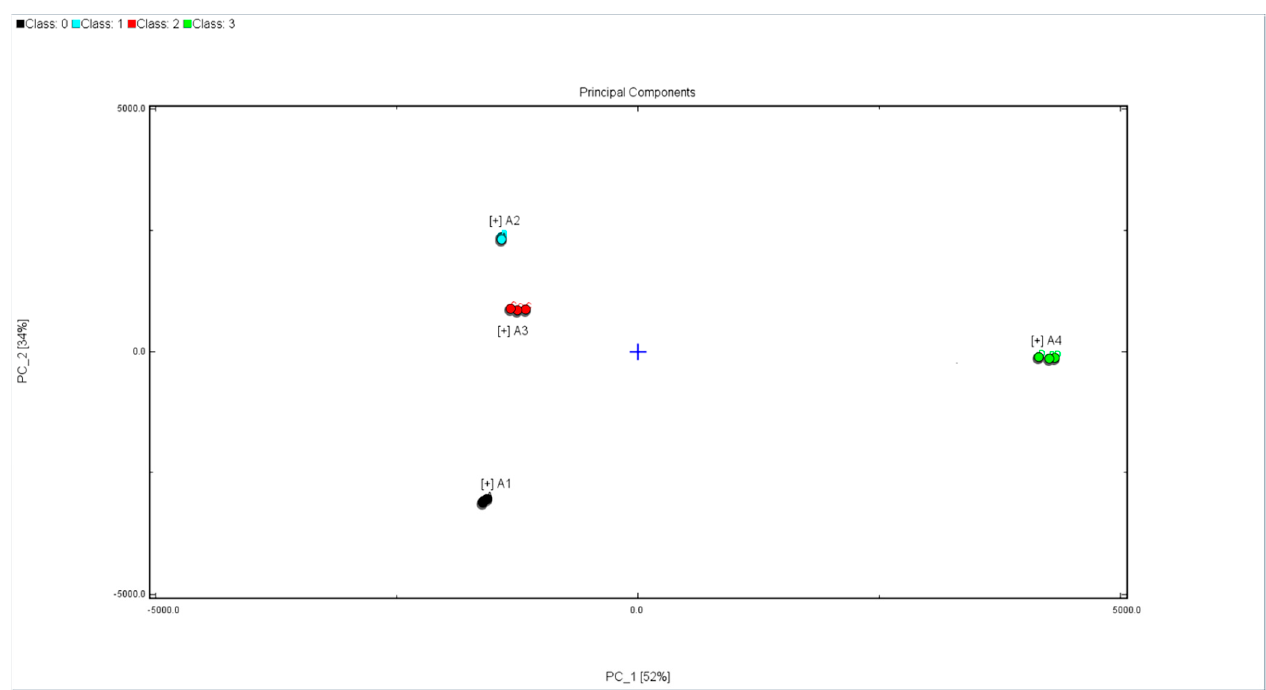
Figure 3. PCA scores plot of preprocessed HS-GC-IMS spectra of Fennel honey, Agastache honey, Pomegranate honey, and Manuka 12+ honey. A1: Fennel honey; A2: Agastache honey; A3: Pomegranate honey; A4: Manuka 12+ honey.